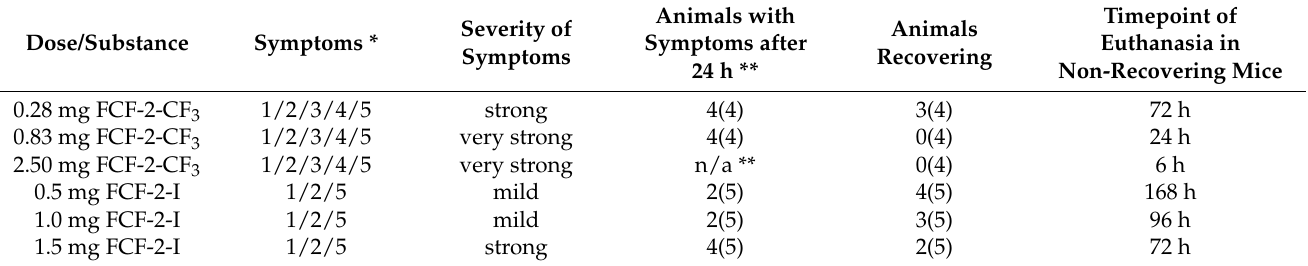
Table 1. Summary of the results from the in vivo mouse experiments with FCF-2-CF 3 and